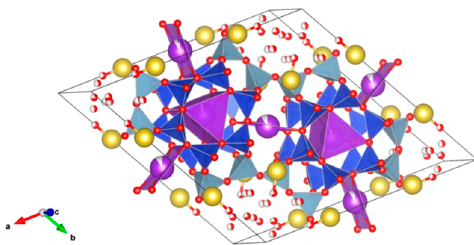
Figure 16. Zeolites. X x / n [(AlO 2 ) x (SiO 2 ) y ] (where Xn + is the charge balancing counter-ion). Structure depends on chemical composition. Cations can be Na, K, NH 4+ , Cs, Mg, Ca, Sr, Co, Fe, Ga, REE and Ti.